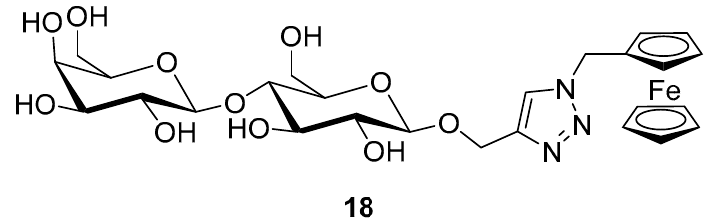
Figure 1. Chemical structure of compound 18 .